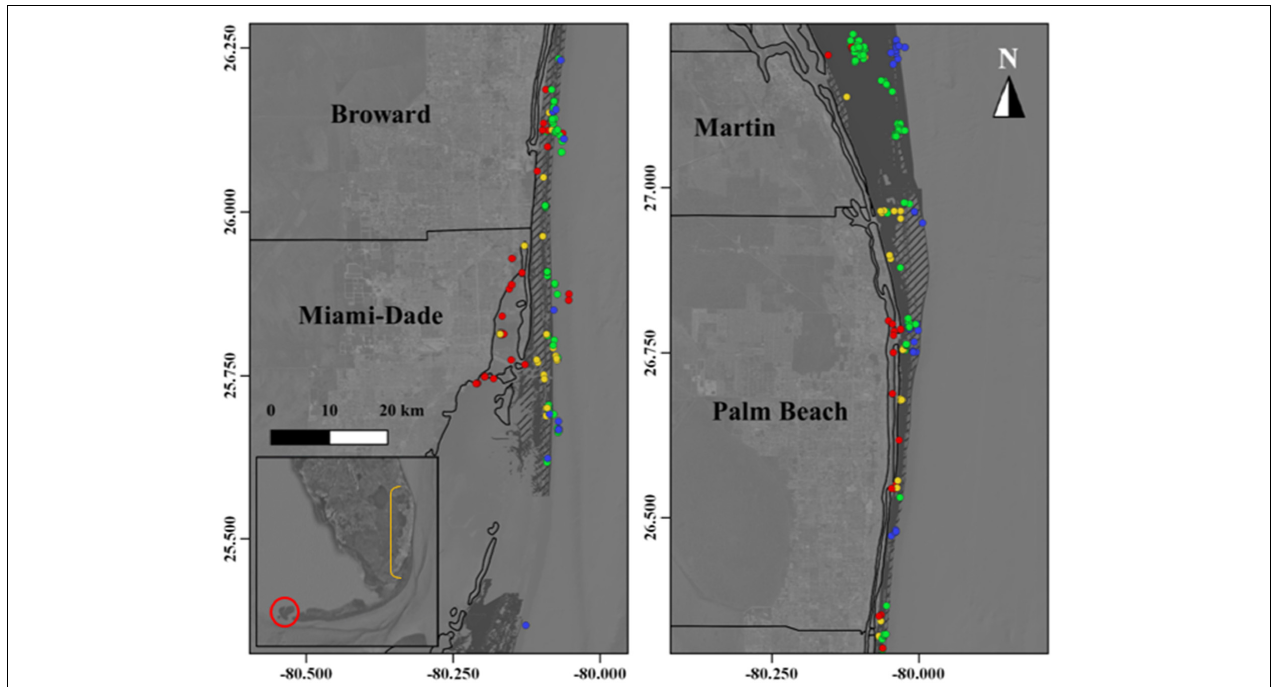
FIGURE 2 | The Florida Reef Tract extends from the Dry Tortugas (Inset–red circle) to the northern extent of Martin County, Florida (north). Comprised of a range of habitats, harbottom limestone reefs (dashed gray polygons) are surrounded by unconsolidated sandy bottom (dark-gray polygons) in the Southeast Florida Coral Reef Ecosystem Conservation Area. Artificial reefs are distributed throughout the region at a range of depths. Colored circles represent reefs at depths between 1 and 25 m (red circles), 26–50 m (yellow circles), 51–75 m (green circles), and 75–100 m (blue circles). Ecosystem Conservation Area counties are labeled, and boundaries denoted by black